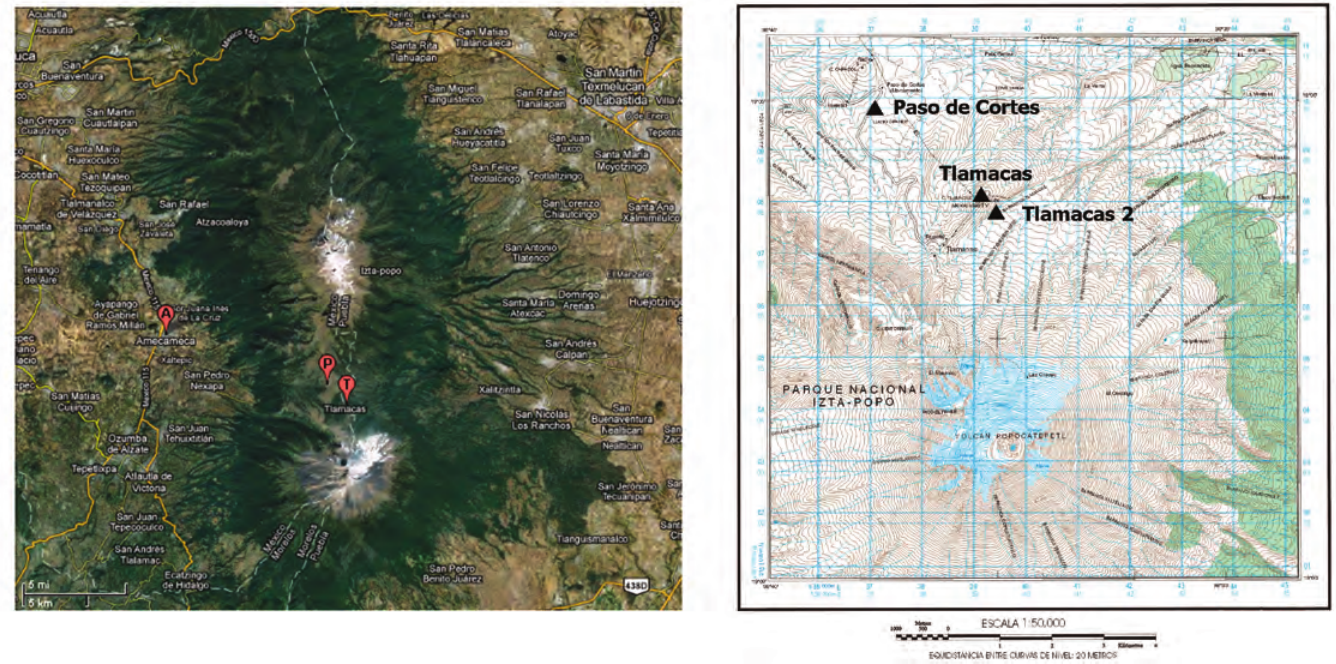
Figure 1. Left: Map showing the Amecameca referent site (A), and the Paso de Cortes (P) and Tlamacas (T) Sites. Right: Map of volcanic area showing the Paso de Cortes, Tlamacas and Tlamacas 2